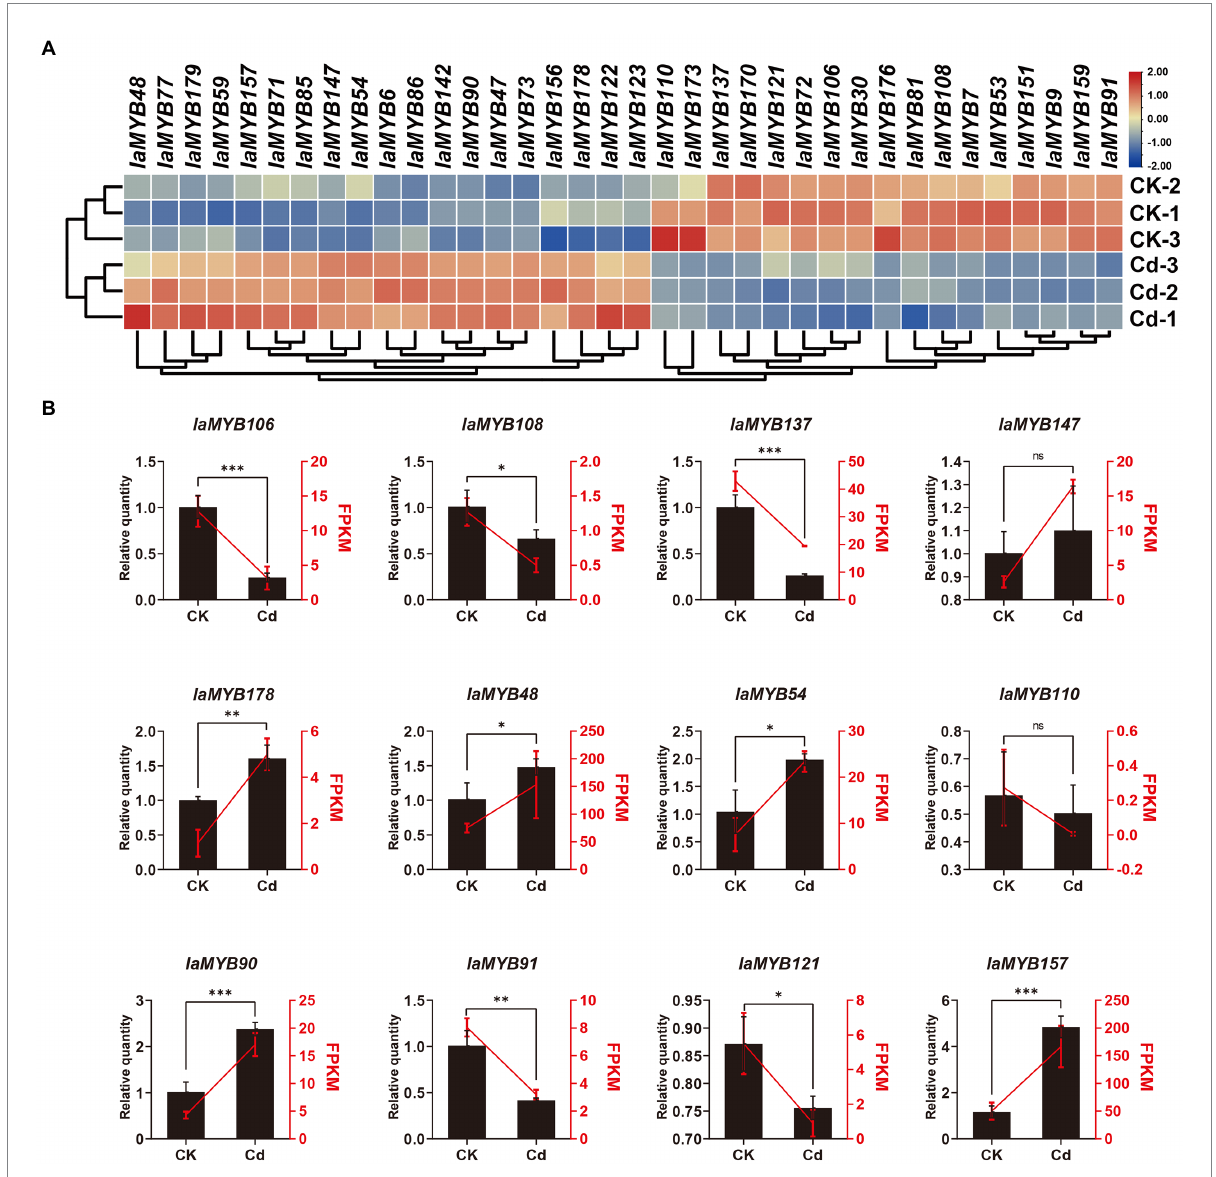
FIGURE 7 The expression patterns of the 36 DEGs. (A) Heatmap showing expression patterns of the 36 DEGs. (B) The expression of the 12 randomly selected DEGs validated by qRT-PCR. The CK represents the root samples in the control group, whereas the Cd represents the root samples in the Cd- treated group. Left Y-axis and black histograms indicate the relative expression levels quantified by qRT-PCR. The right Y-axis and red lines indicate FPKM values obtained by RNA-seq. The statistical analysis was performed using the student’s t -test. Data shows mean ± SD of three replicates (ns: no significance, * p < 0.05, ** p < 0.01, and *** p <